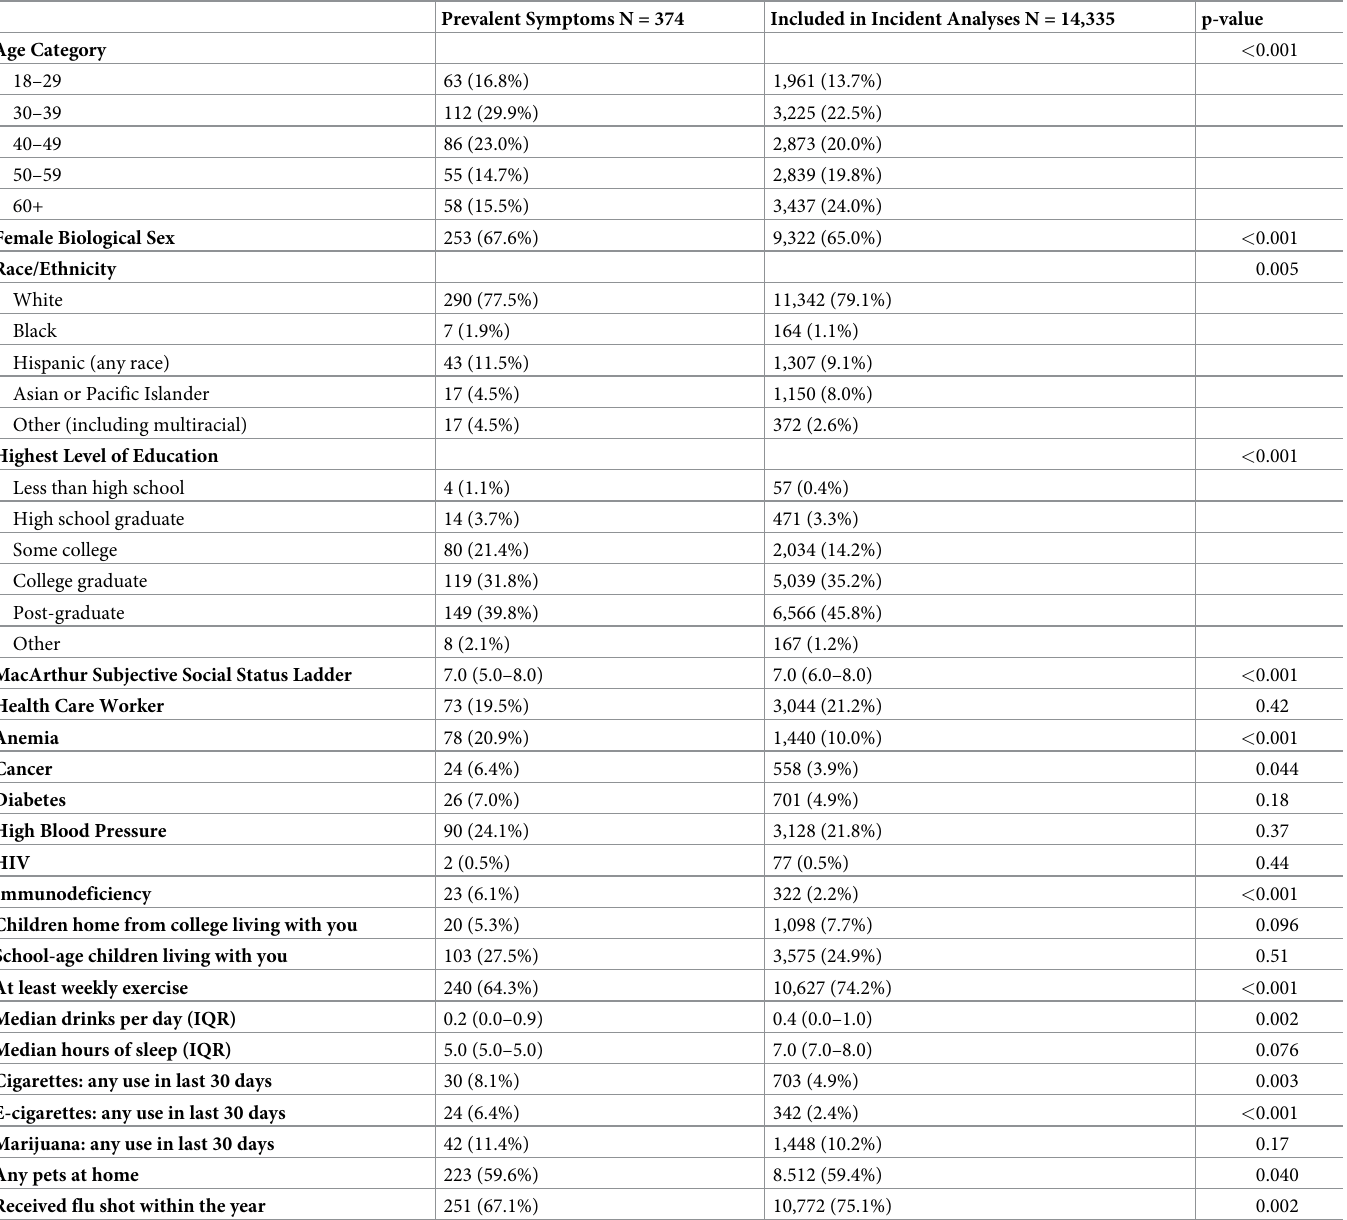
Table 1. Baseline characteristics of participants with and without prevalent viral